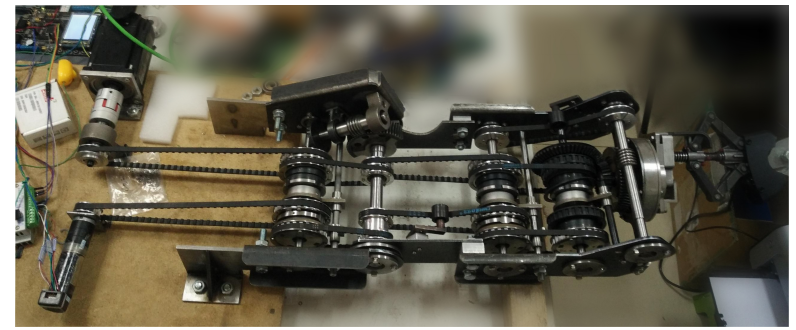
Figure 25. The manipulator is tested on a table.